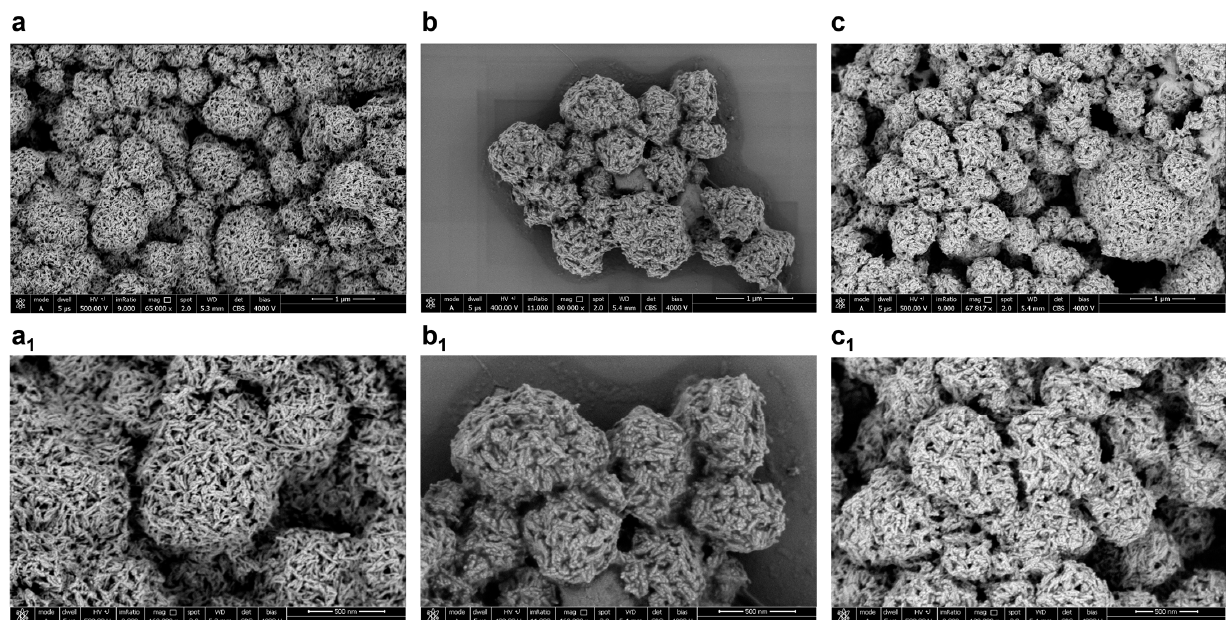
Figure 5. SEM image of: ( a , a 1 ) HA 65,000×, scale bar 1 µm, and 160,000×, scale bar 500 nm respectively; ( b , b 1 ) HA–Lacto 80,000×, scale bar 1 µm, and 160,000×, scale bar 500 nm respectively; ( c , c 1 ) HA–Lacto–Que 68,000×, scale bar 1 µm, and 130,000×, scale bar 500 nm respectively.